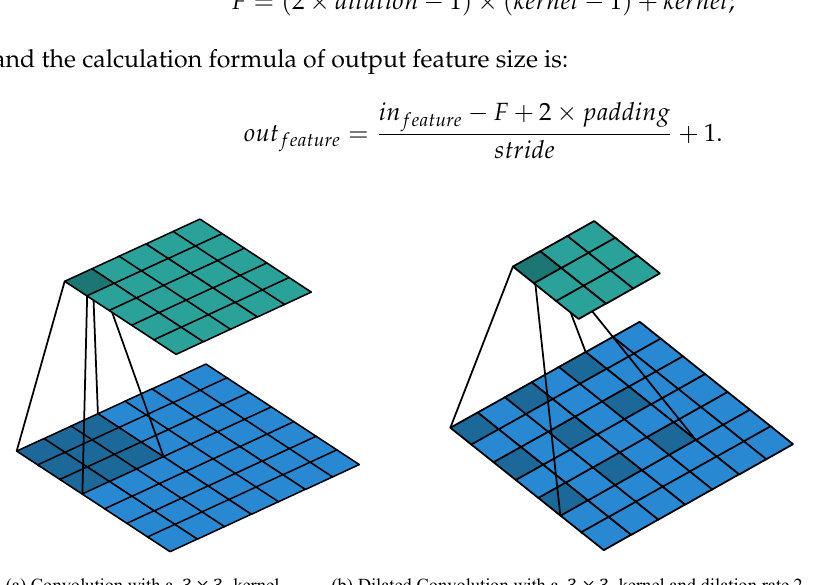
Fig .7 Structure of improved U-net. The role of dilated convolution in the improved U-net structure is to expand the receptive field [30]. The schematic diagram of its work is shown in Fig. 8(b). In Fig. 8, the stride of convolution is 1 and no padding operation is performed. It can be seen from Fig. 8 that by using dilated convolution with a kernel and a dilation rate of 2, the receptive field of each convolution is amplified from to . In this way, each convolution output contains a large range of 3 × 3 information of the original feature map, and appropriately compensates for some feature loss 3 × 3 5 × 5 caused by the pooling operation in the U-net network [31].